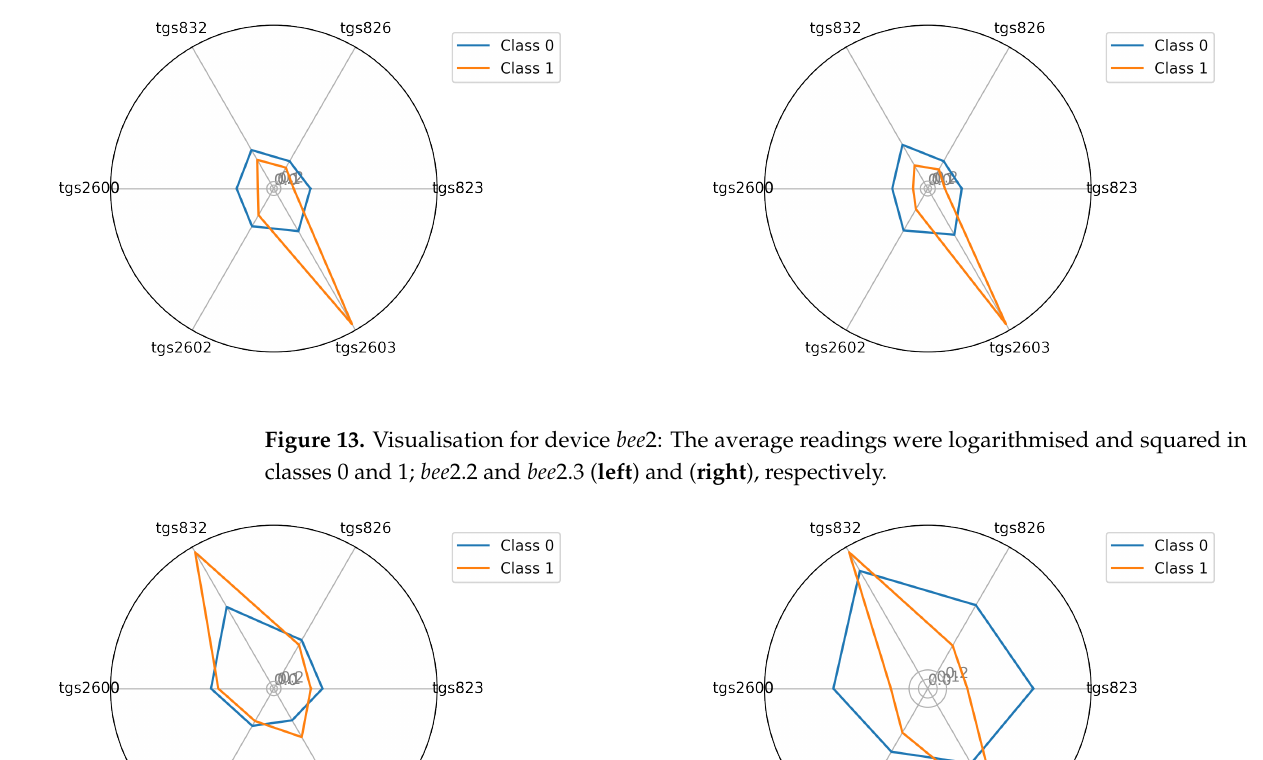
Figure 12. Visualisation for device bee 1: The average readings were logarithmised and squared in classes 0 and 1; bee 1.2 and bee 1.3 ( left ) and ( right ), respectively.